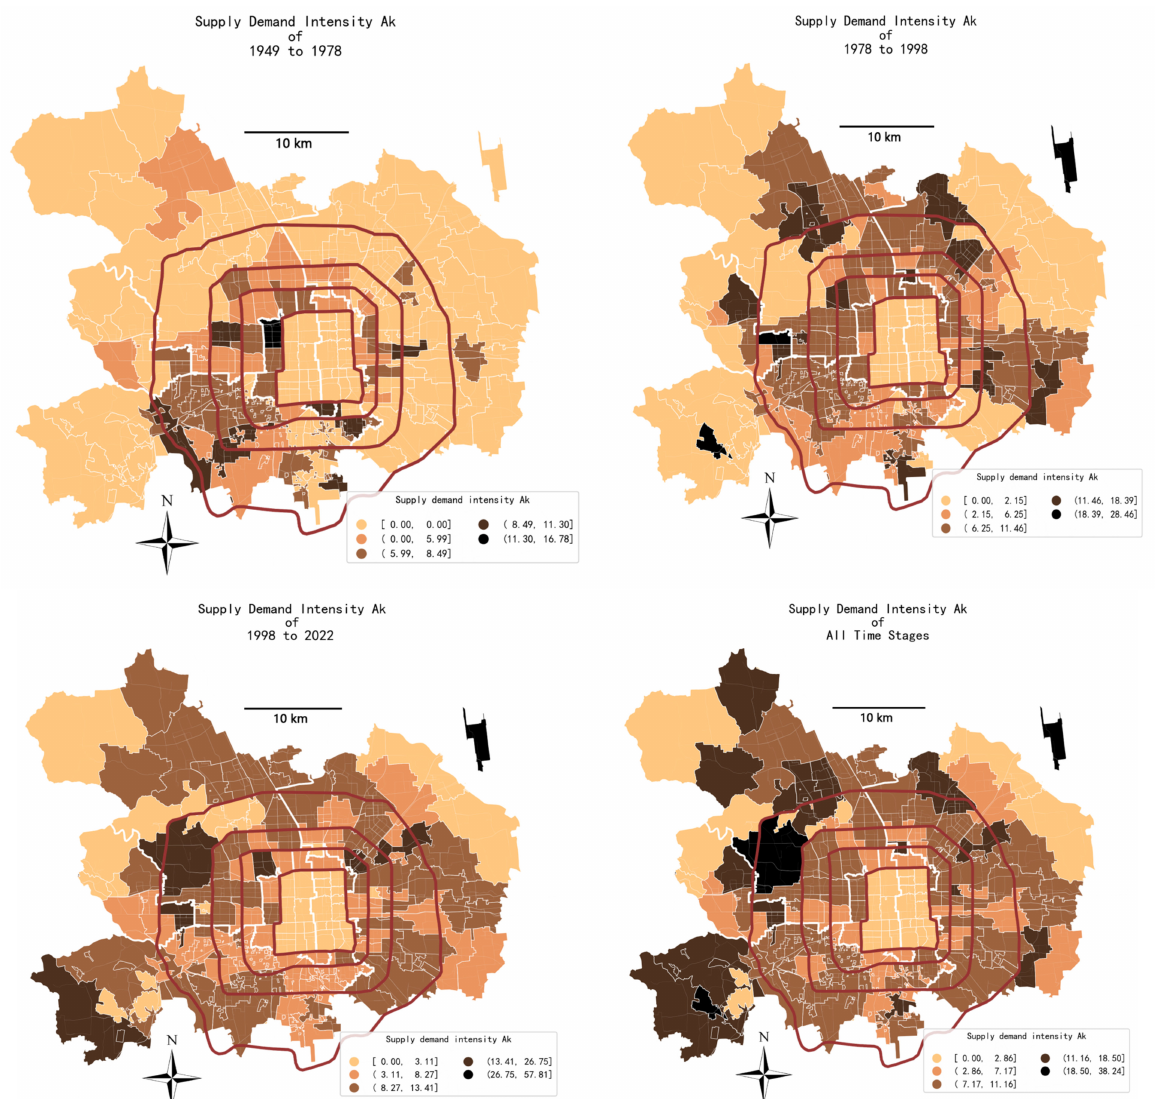
Figure 8. The spatial-temporal patterns of the 2SFCA